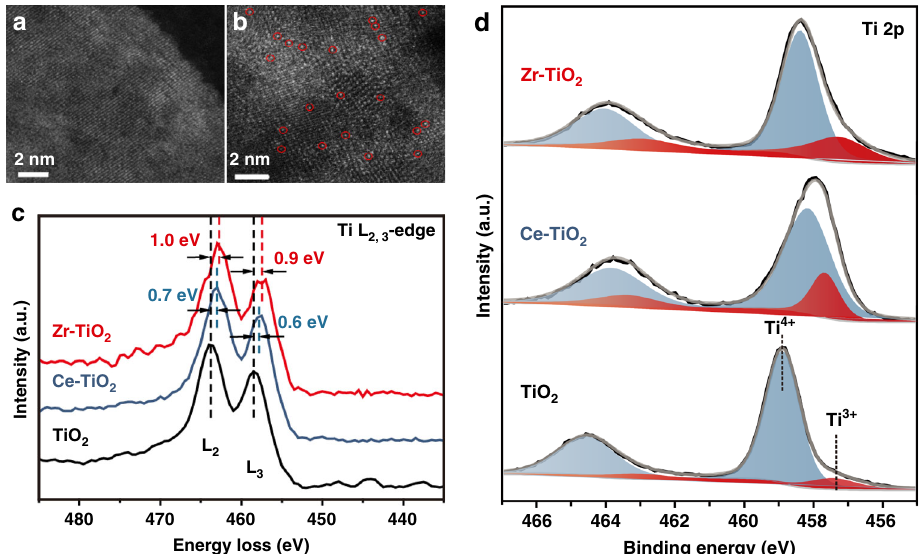
Fig. 5 Structural and compositional characterizations. High-angle annular dark- fi eld scanning transmission electron microscopy (HAADF-STEM) of a undoped TiO 2 and b Zr-TiO 2 samples. Single Zr 4 + ions were highlighted by red circles. c Electron energy loss spectroscopy (EELS) pro fi les of the Ti-L 2, 3 edge recorded across the undoped TiO 2 , Ce-TiO 2 , and Zr-TiO 2 samples. d Ti 2p X-ray photoelectron spectroscopy (XPS) spectra of the Zr-TiO 2 , Ce-TiO 2 , and undoped TiO 2 , samples. (Source data are provided as a Source Data fi